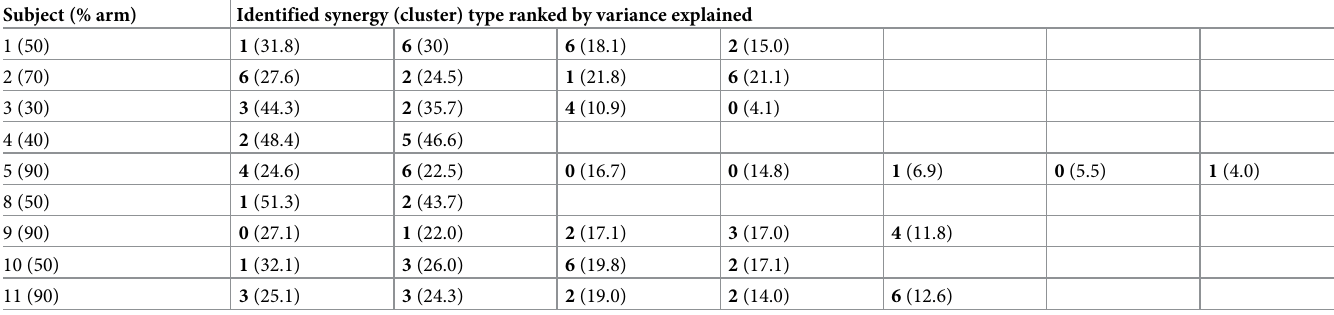
Table 4. Classification of synergy type in amputee subjects with respect to the synergy clusters of able-bodied